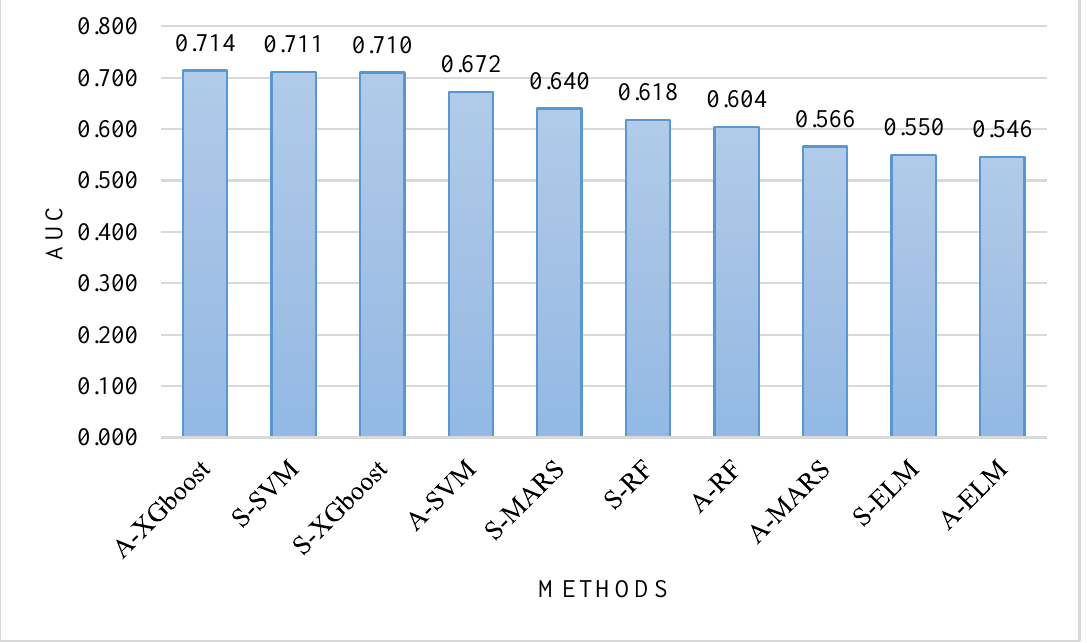
Table 5. Evaluation of the ten models based on the averaged classification results.